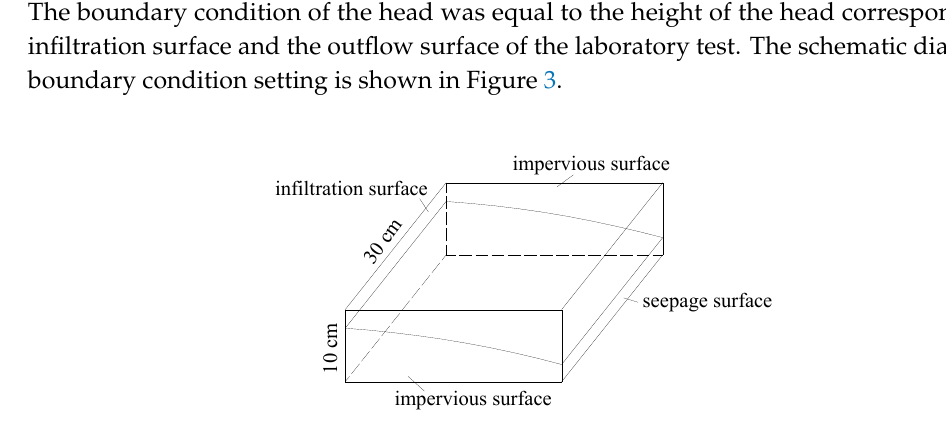
Figure 2. Geometric model of geometry for the calculation of infiltration on a drainage asphalt pavement. (4) Establish boundary conditions This three-dimensional infiltration finite element software simulated the indoor one-sided water storage test of the drainage asphalt mixture rut. The infiltration model can be built with